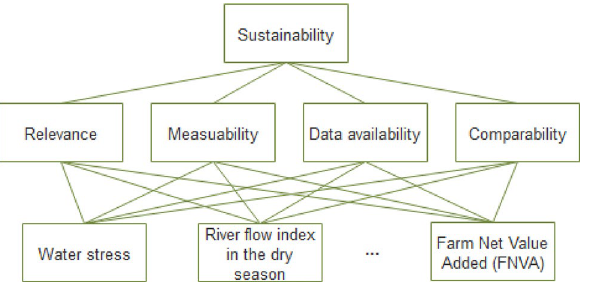
Figure 3. The hierarchy adopted in this study. It has one goal (sustainability, the first level), four criteria (intermediate level) and 17 SPIs (third or inferior level).